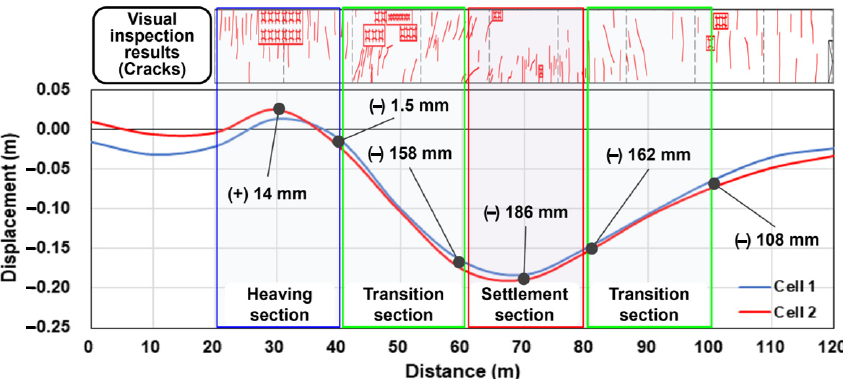
Figure 3. Comparison between optical leveling and visual inspection results for each section.